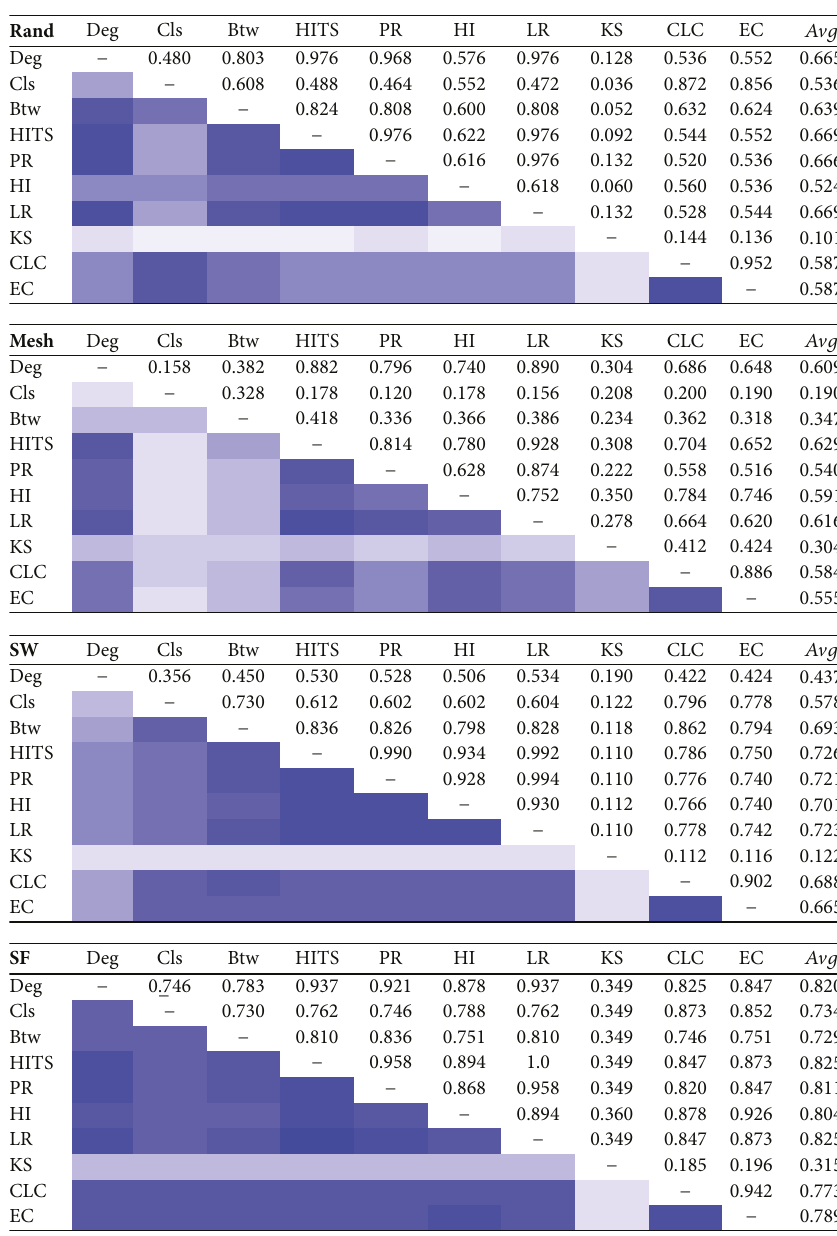
i , j ~cell j , i . A stronger blue intensity denotes a colour value